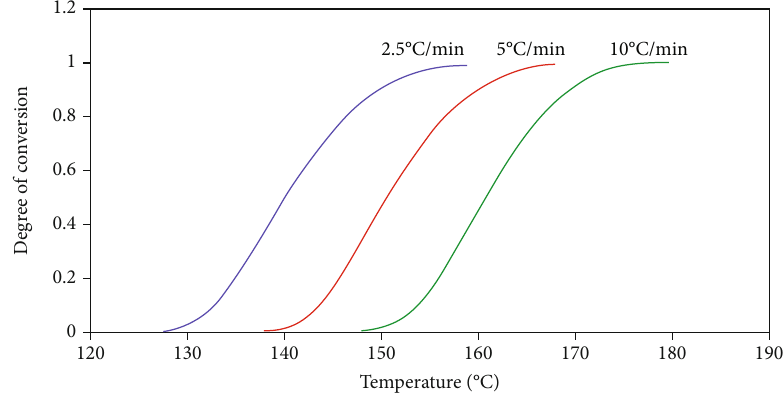
Figure 10: The degree of conversion versus temperature for uncured